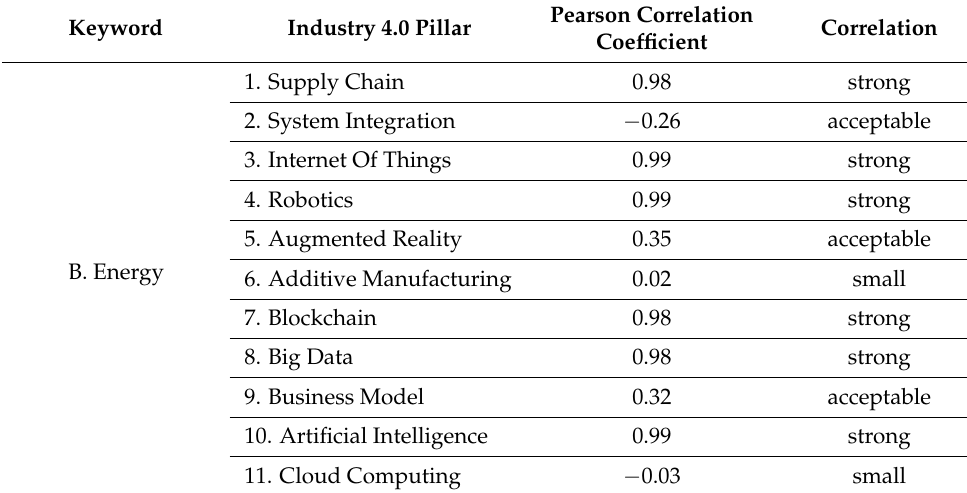
Table 5. Correlation matrix for “Energy” and the Industry 4.0 pillars.